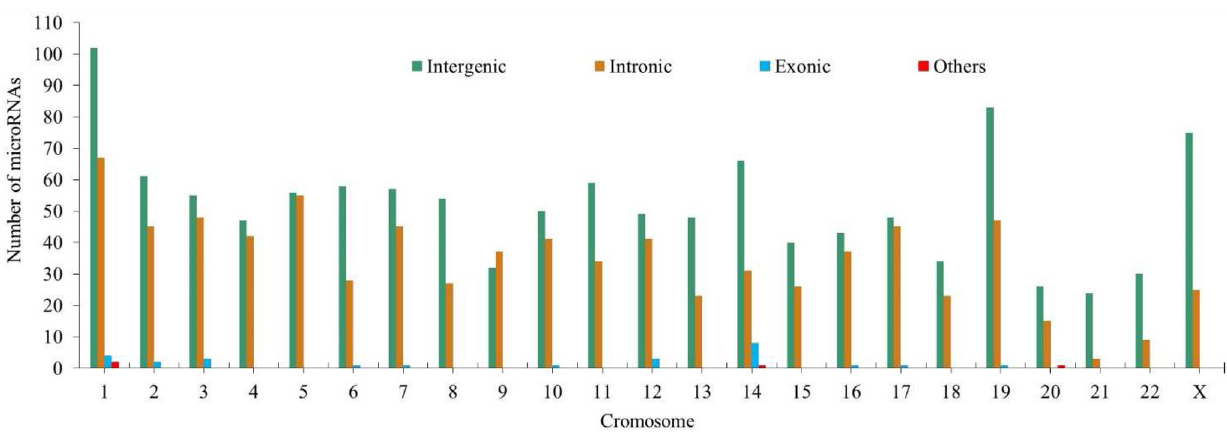
Figure 5. Numeric variation of miRNAs associated with the development of CC in different genomic locations (intergenic, intronic and exonic) per